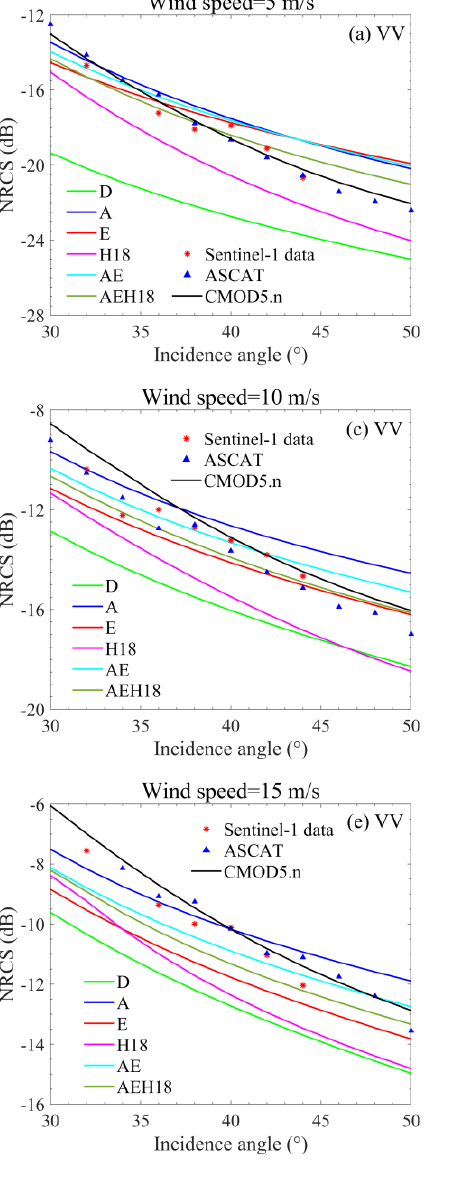
Figure 4. Predictions of the conventional TSM based on the four wind wave spectra of D, A, E, and H18 and two composite spectra of AE and AEH18 and their comparison with the Sentinel-1 data, ASCAT data, and empirical model as functions of the incidence angle at wind speeds of ( a , b ) 5 m/s, ( c , d ) 10 m/s, and ( e , f ) 15 m/s in the upwind direction under VV and HH polarizations. Green curve, D spectrum; blue curve, A spectrum; red curve, E spectrum; magenta curve, H18 spectrum; cyan curve, AE composite spectrum; dark green curve, AEH18 composite spectrum; star point, Sentinel-1 data; triangle point, ASCAT data; dark curve, empirical model.